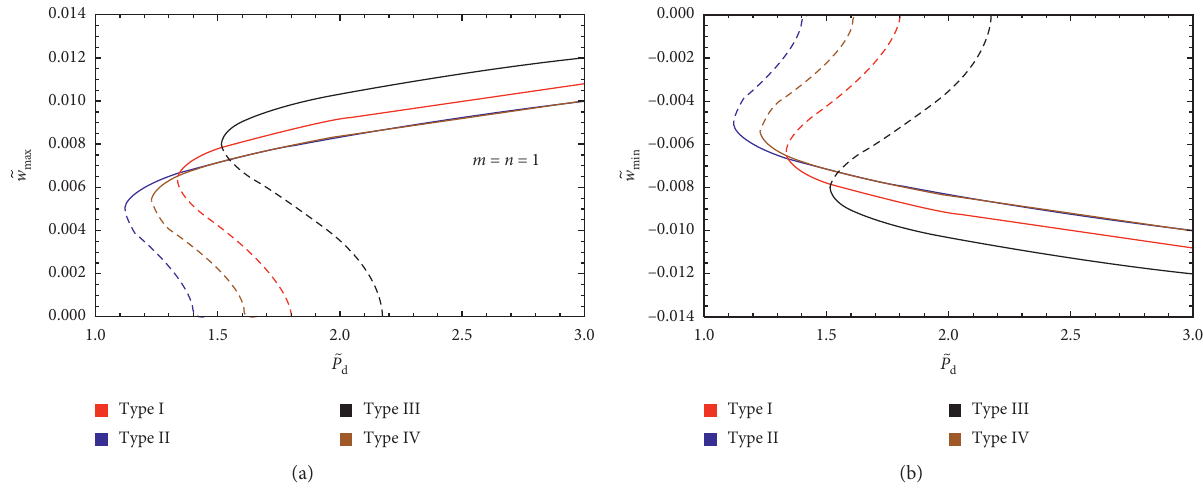
Figure 11: Force-response curves of different type of BDFG beam with m � n � 1, L / h � 20, 􏽥 c (a, b) Maximum and minimum amplitudes of transverse motion 􏽥 w .